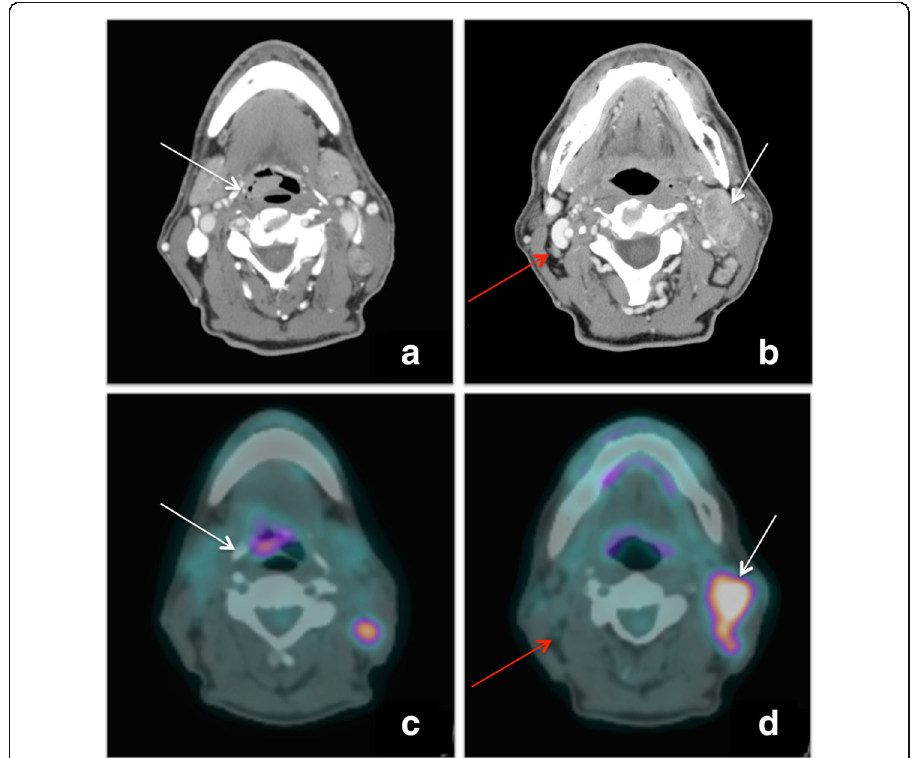
Fig. 1 a transaxial c.e.CT: primary epiglottic lesion. b transaxial c.e.CT: lateral cervical lymph nodes. c transaxial PET/CT: hypermetabolic primary epiglottic lesion. d transaxial PET/CT: not pathological right lateral cervical lymph nodes, left hypermetabolic lateral cervical